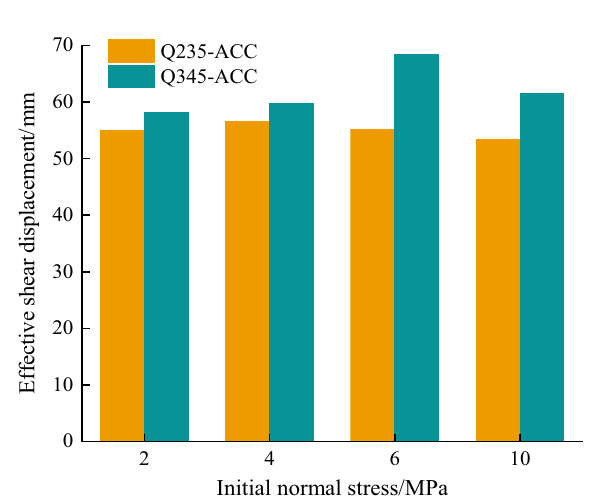
Figure 10. Shear force–shear displacement curves of the ACC-reinforced jointed rock masses.